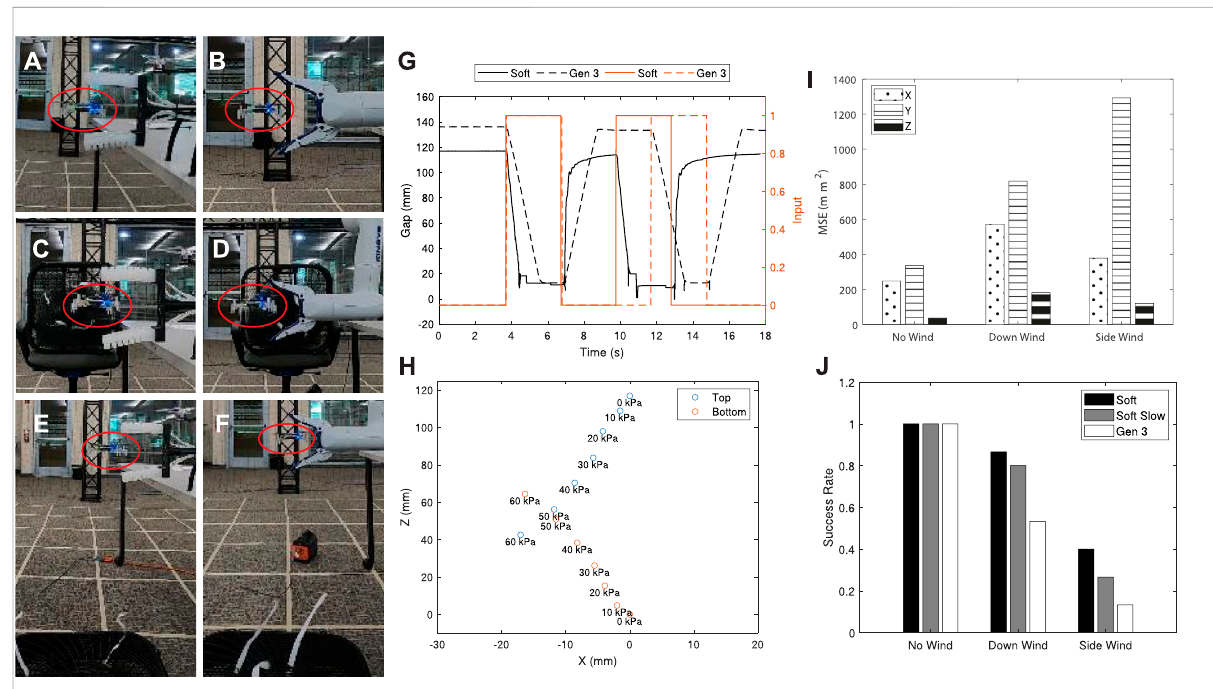
FIGURE 6 Grasping test for the soft and Gen3-lite grippers. (A – F) Both grippers are placed vertically at the same 3D position and studied in three cases: no-wind, down-wind, and side-wind. (G) Step response for both grippers. (H) Relative positions of the soft gripper ’ s two claws with respect to different pressure values. (I) Mean squared error for a hovering micro-robot under disturbances. (J) Success rates for horizontal grasping of a fl ying micro-robot using both